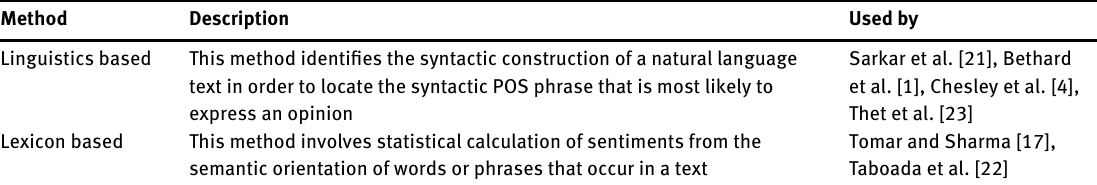
Table 1: Summary of the Reported